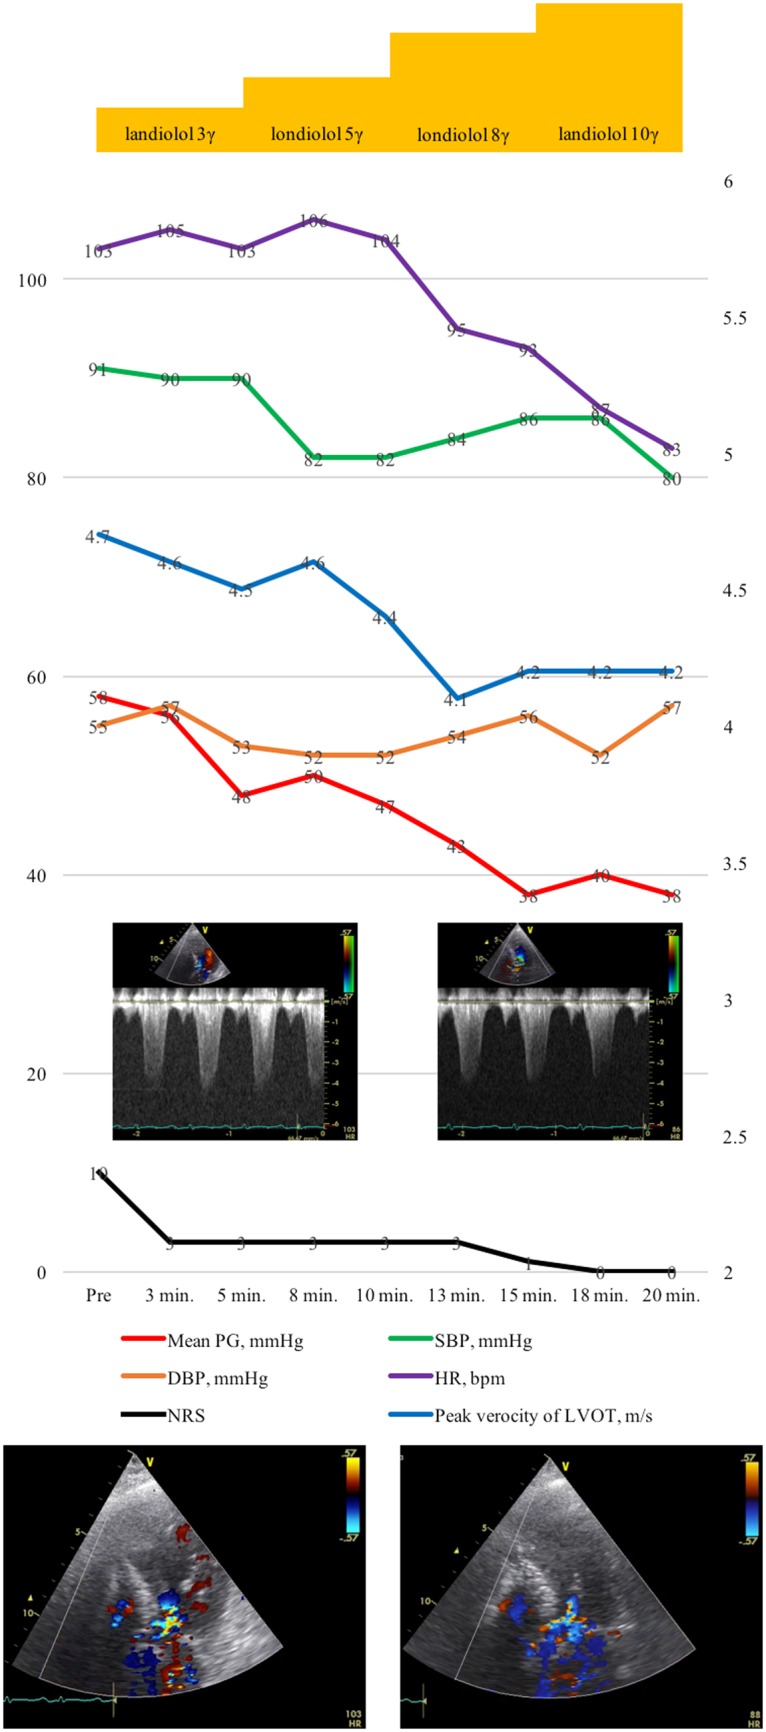
Clinical course of peak velocity and mean PG of LVOT, vital signs and symptoms. DBP, diastolic blood pressure; NRS, numerical rating scale of chest pain; PG, pressure gradient; SBP, systolic blood pressure. Note: Apical five chamber view of pre-landiolol (bottom left) and post-landiolol (bottom right) of echocardiography.